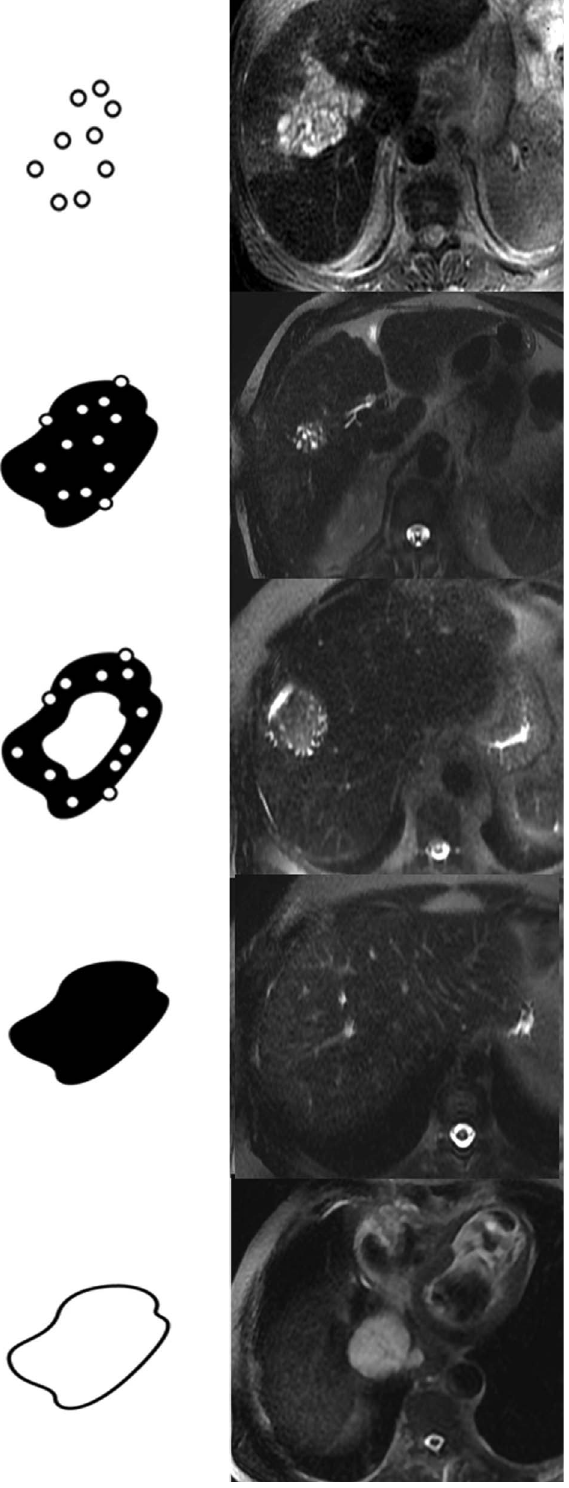
Figure 1. Schematic drawings (left) and T2-weighted MR images (right) of AE lesions show (top – down) the fi ve types in the Kodama classi fi cation: type 1 multiple small round cysts without a solid component; type 2 multiple small round cysts with a solid compo- nent; type 3 a solid component surrounding large and/or irregular cysts with multiple small round cysts; type 4 a solid component without cysts; type 5 a large cyst without a solid